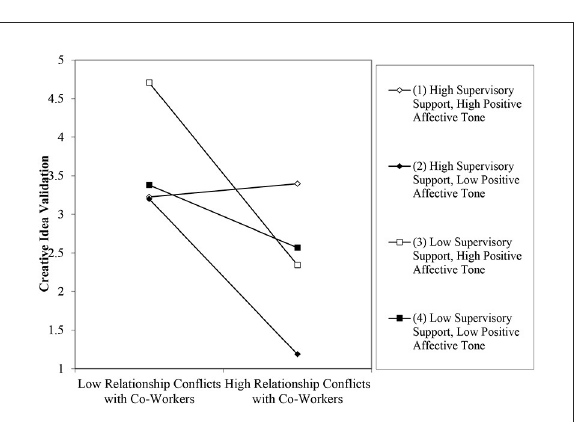
FIGURE4 Plot of interaction between relationship conflicts with co-workers, supervisory support, and positive affective